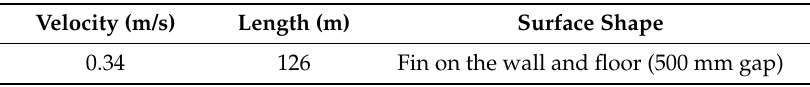
Table 9. The optimized conditions of the thermal labyrinth design.